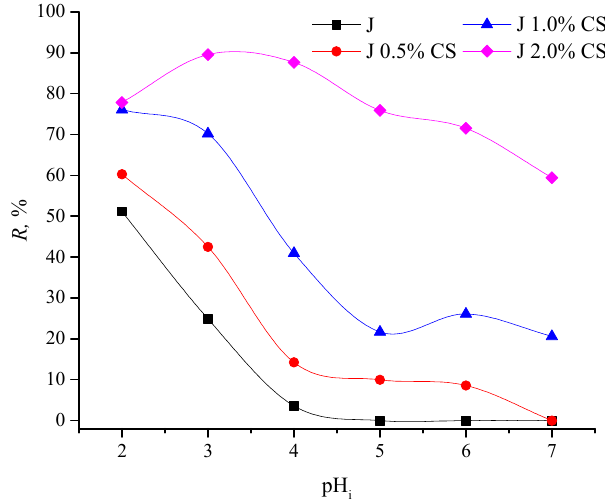
Figure 6. The impact of the solution’s initial pH (pH i ) on the removal ( R ) of RO 16 by different adsorbents ( c 0 = 25 mg/L, t = 21 h, T = 25 °C, the adsorbent mass of 0.50 g).